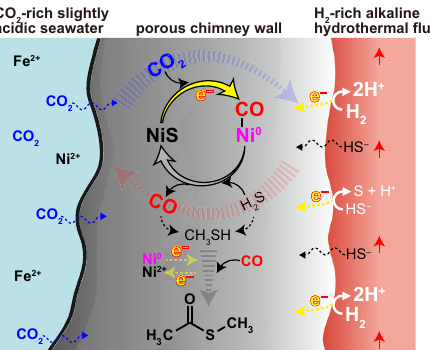
Fig. 3 Schematic cross-section of a vent chimney in a primordial ocean alkaline hydrothermal system showing possible abiotic thioester synthesis promoted by Ni sul fi de_PERM. Note that the availability of methanethiol in primordial deep-sea vent environments remains controversial and needs further investigation